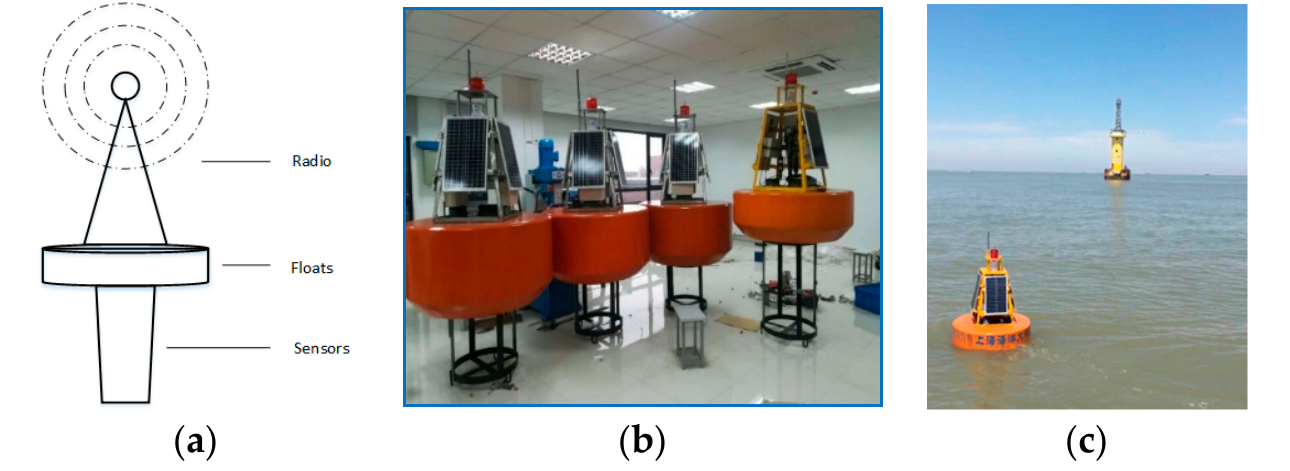
Figure 1. The nodes in the aquaculture network of tracking targets adopted in the environment for our aquaculture sensor network. ( a ) Schematic diagram of the structural representation of nodes. ( b ) Buoys equipped with sensors in this network. ( c ) Layout representation of tracking system in this aquaculture network.